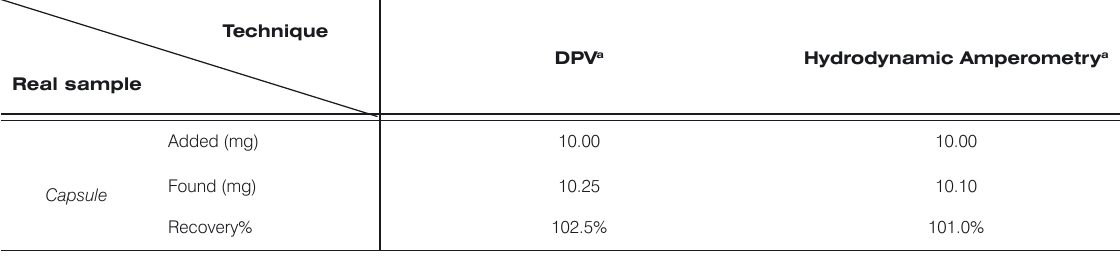
a mean of the four repetitions